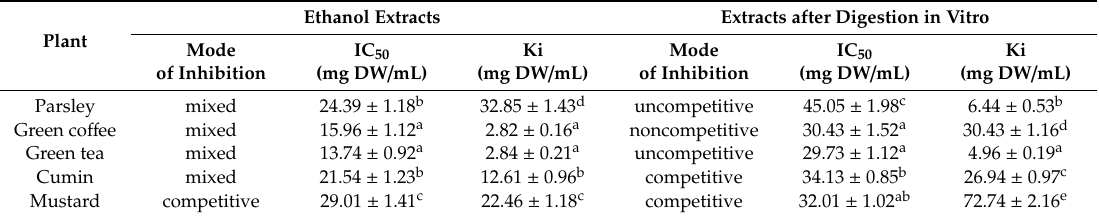
Table 5. IC 50 value, Ki value, Vmax value, and mode of LOX inhibition by ethanol and digested extracts from parsley, cumin, green tea, green co ff ee, and mustard ( n = 9).